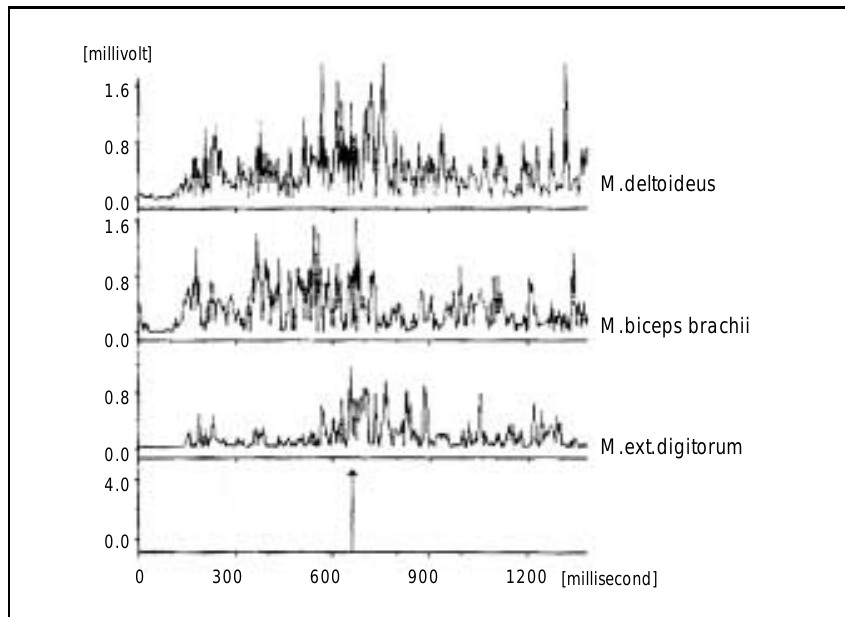
Figure 3: Electromyographic example of the hemiparetic limb of a patient in the abduction movement.